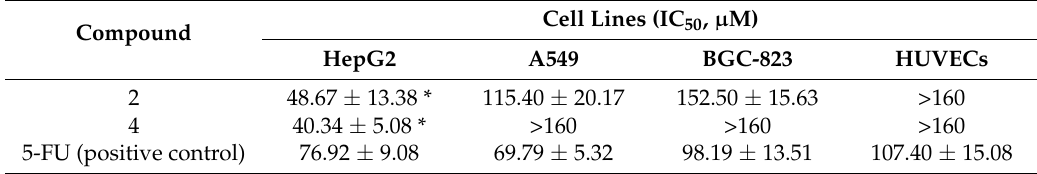
Table 3. IC 50 values for compounds 2 , 4, and 5 - FU in different cell